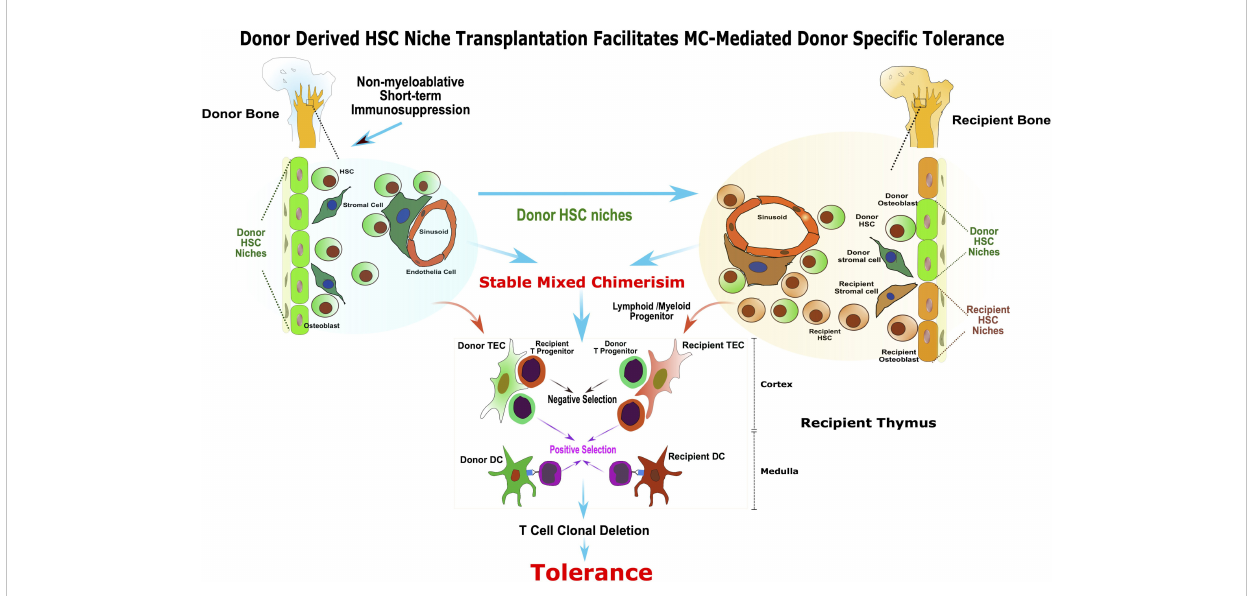
FIGURE 6 Donor derived HSC niche transplantation facilitates MC-mediated donor speci fi c tolerance. The presence of functional donor derived HSC niche is required for the maintenance of stable MC. The vascularized bone graft bears donor HSC niche enabling sustained donor-derived HSC/ mesenchymal stem cells production, homing and renewal, and facilitate stable MC and tolerance without harsh myeloablation. In addition, the transplanted donor HSC niche in VCA facilitated the donor HSC niche seeding to the recipient bone marrow compartment and contributed to the maintenance of homeostasis of stable MC. The co-existence of donor and recipient derived stromal cell and DC in recipient ’ s thymus as a result of stable MC may provide the cellular mechanisms for alloreactive T cell central deletion and allograft